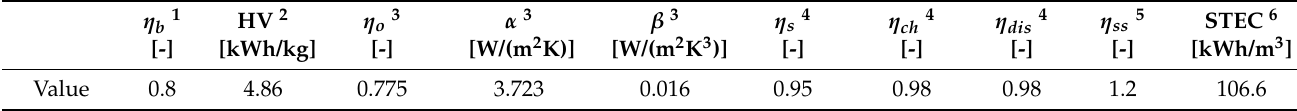
Table 1. Value of the parameters of the EH model.